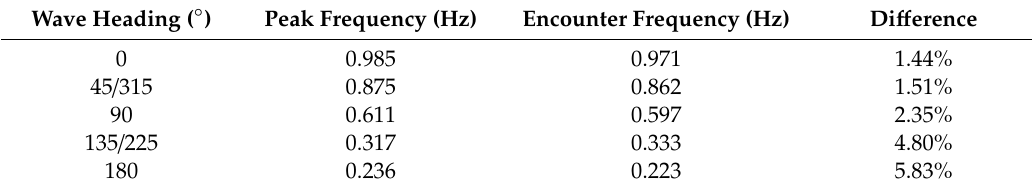
Figure 12. Frequency domain results of ship encounter wave. Table 3. Comparison of the peak frequency with encounter